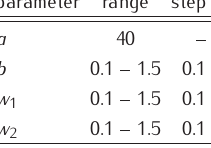
Table 1. A search space for soft MFM parameters Figure 3. ASR Performance for the center loudspeaker in a word correct rate.